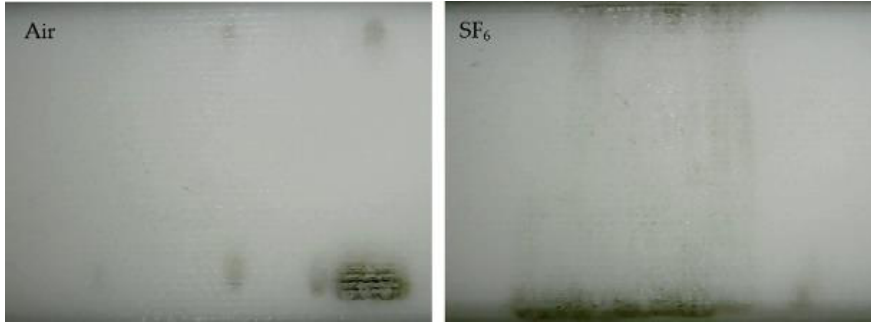
Figure 16. Image of discharge traces after 100 flashovers in air and SF 6 , respectively.